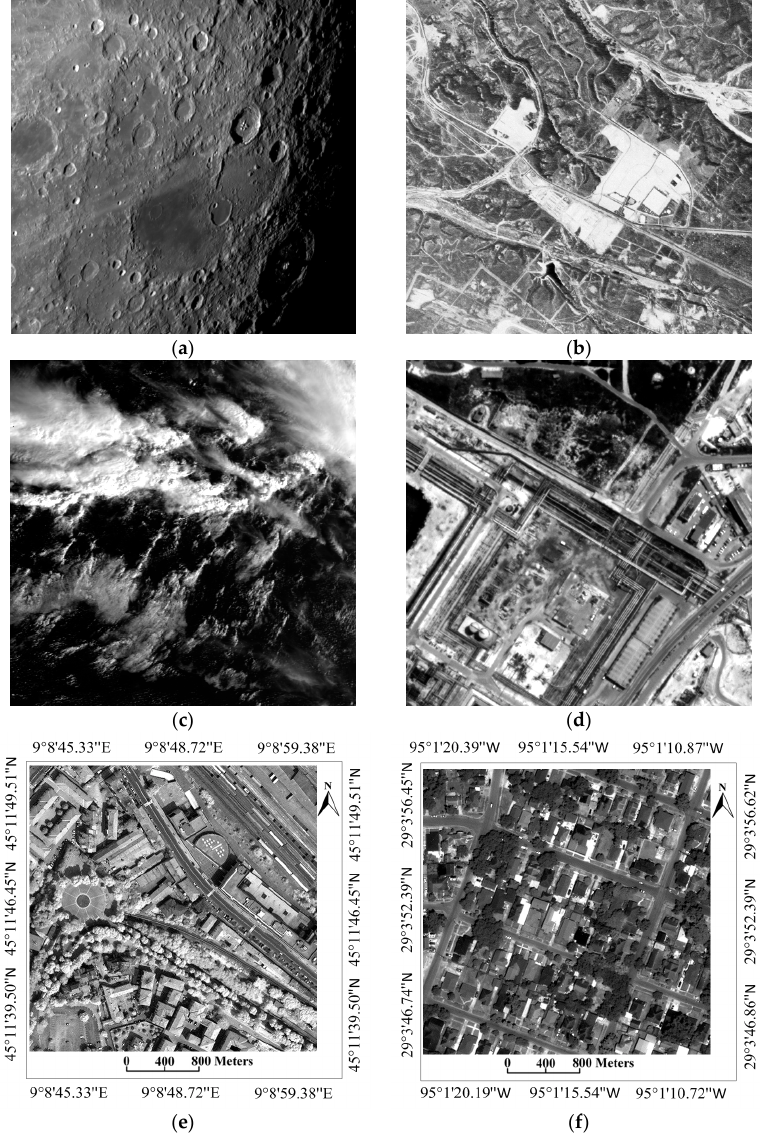
Figure 8. The test remote sensing image set. ( a ) Lunar, ( b ) Miramar NAS, ( c ) ocean_2kb1, ( d ) pleiades_portdebouc_pan, ( e ) Pavia, and ( f ) Houston.